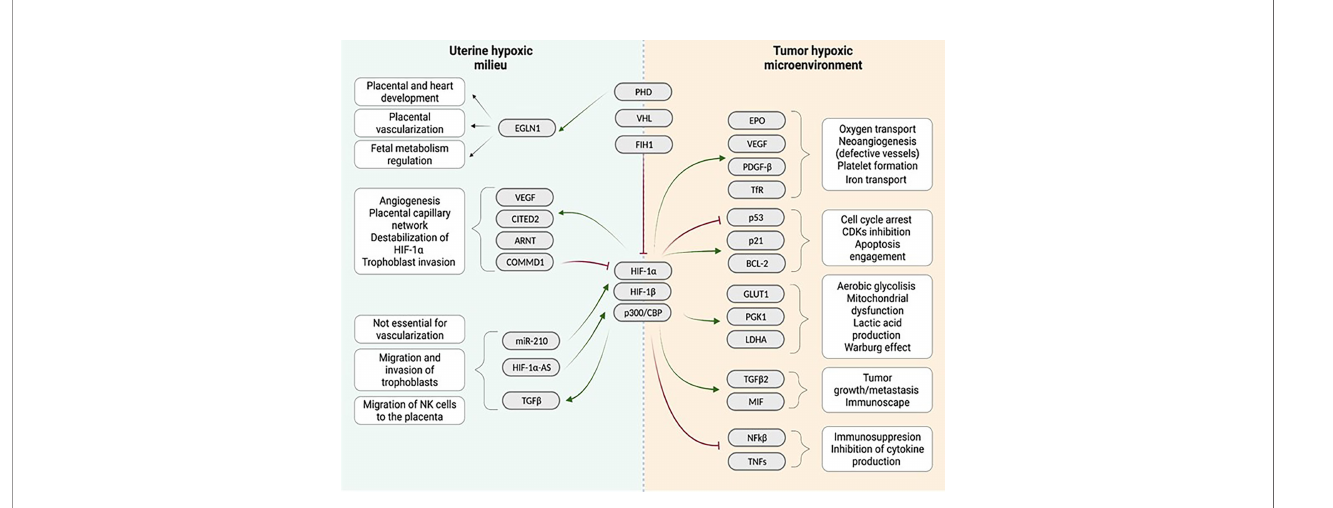
FIGURE 1 | Comparison of the uterine hypoxic milieu and the tumor environment regarding the in fl uence of the hypoxia associated gene cascade: Both niches show different interactions with a quite similar range of genes identi fi ed in the downstream cascade following hypoxia induction in the tissue. Similarities between both niches are enhanced vascularization after hypoxia induction. (Red arrows indicate inhibition, green arrows indicate activation). Created with